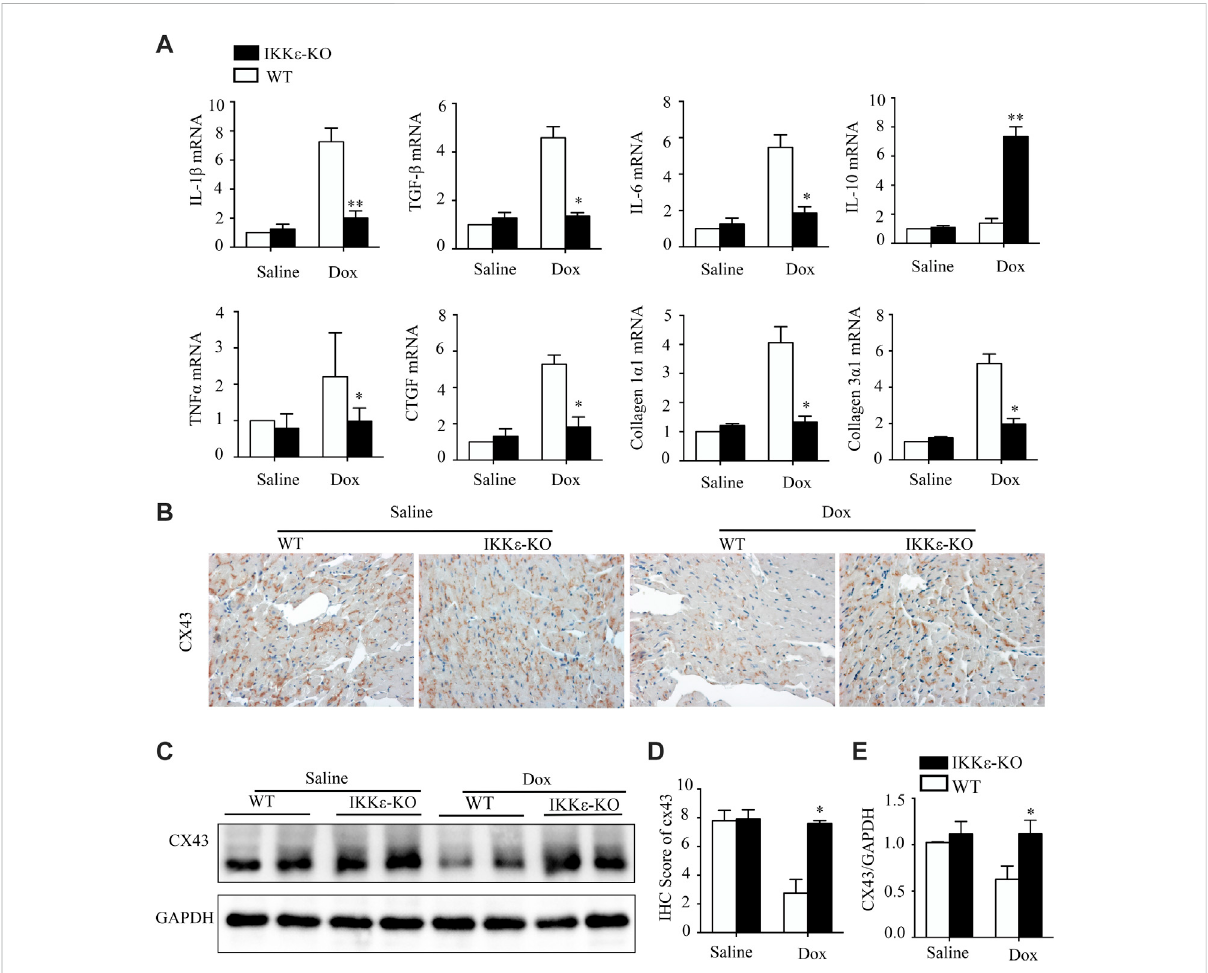
FIGURE 3 IKK ε knockout relieved heart failure, fi brosis, in fl ammation, and destruction of gap junction structure after Dox induction. (A) . The mRNA analysisofmarkersofIn fl ammatorycytokines(IL-6,IL-1 β ,TNF- α ,andIL-10),andcollagen-relatedfactors(CTGF,TGF- β 1,Collagen1a1,andCollagen 3a1)intheheartofWTorIKK ε -KOmiceafterDoxinjection( n =4miceperexperimentalgroup;vs.SalineorWTDox,* p < 0.05). (B,D) .Representative IHC images and analyses of Cx43 in the heart tissues of WT and IKK ε -KO mice after Dox stimulation ( n = 4 mice per experimental group, 400x, vs. Saline or WT Dox, # p /* p < 0.05). (C,E) Representative western blot images and analysis of Cx43 in heart tissue after Dox injection ( n = 4 mice per experimental group, # vs. Saline or WT Dox, p /* p <